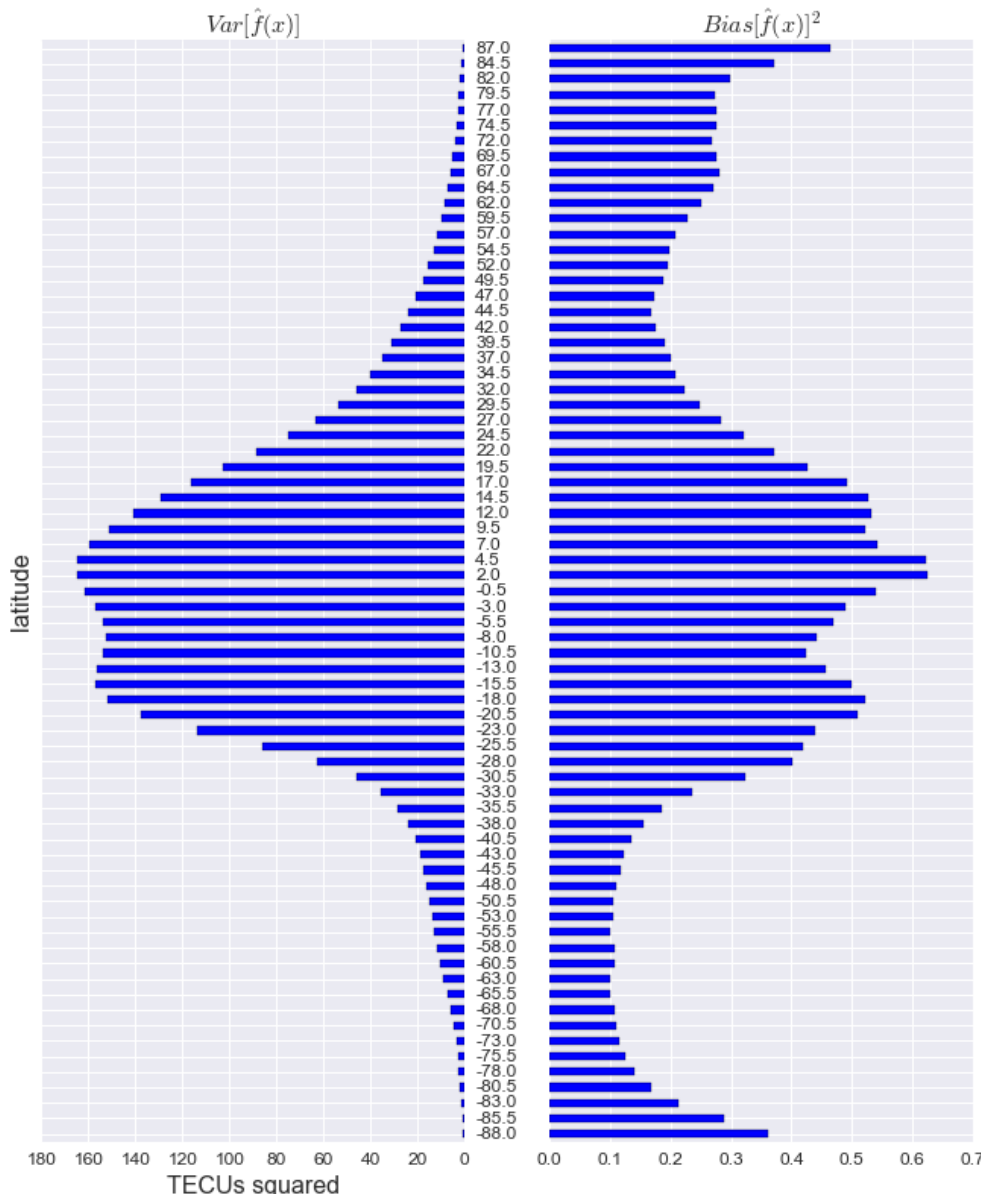
Figure 16. Decomposition of the forecast error variance “ Var [ ˆ f ( x )] ( left ) vs. Bias Bias [ ˆ f ( x )] 2 ( right ). Note that the units are TECUs 2